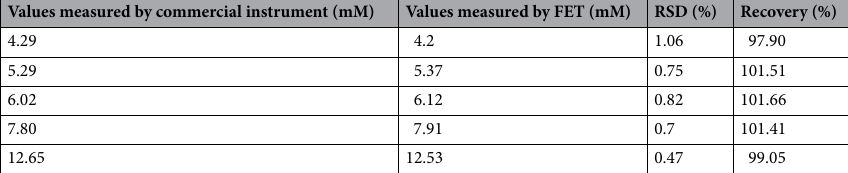
Values measured by commercial instrument